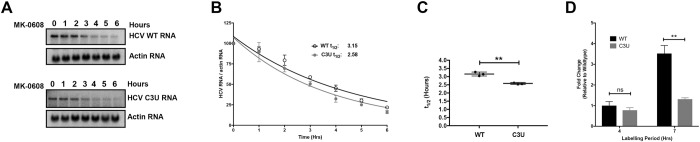
Viral RNA stability and rates of replication in wild-type and C3U variants in the presence of miR-122.(A) Effect of the C3U mutation on HCV RNA decay. Huh7.5 cells were transfected with wild-type and C3U H77.S3/GLuc RNA, treated with 25 μM of MK-0608 three days later, and viral RNA abundances were monitored at specific times after treatment, using Northern blot analyses. (B) One phase decay graph of HCV RNA (R2 = 0.939–0.947) was determined by normalizing HCV RNA levels to loading control actin from three independent experiments. Estimated half-lives (t1/2) of wild-type and C3U RNA are 3.12 hours and 2.6 hours, respectively. (C) HCV RNA half-lives (t1/2) of three independent experiments (**p<0.0018). (D) Rates of RNA replication in wild-type and mutant HCV variant. Three days after HCV RNA transfection, RNA was labeled with 200 μM EU for 4 and 7 hours, conjugated to biotin and subsequently isolated with streptavidin beads. RNA replication rates were determined by RT-qPCR and data is normalized to wild-type HCV four hour labeling time point (**p<0.0047, ns = non-significant).